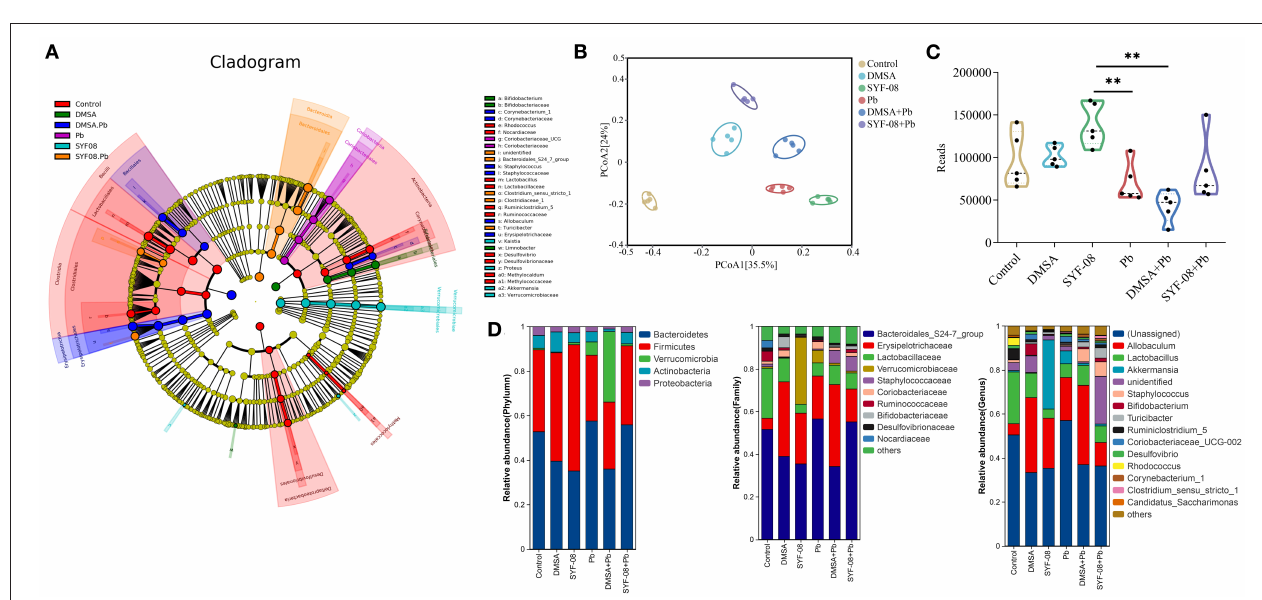
FIGURE 5 | Lactobacillus casei SYF-08 restores Pb-induced intestinal microflora dysbiosis. (A) LEfSe analysis in the Control, Pb, SYF-08, DMSA, SYF-08 + Pb, and DMSA + Pb groups. (B) PCoA scatterplot displaying overall bacterial community composition in the different groups. (C) Reads indices in the different groups. (D) Relative abundance of intestinal microflora composition at different level. ** P <